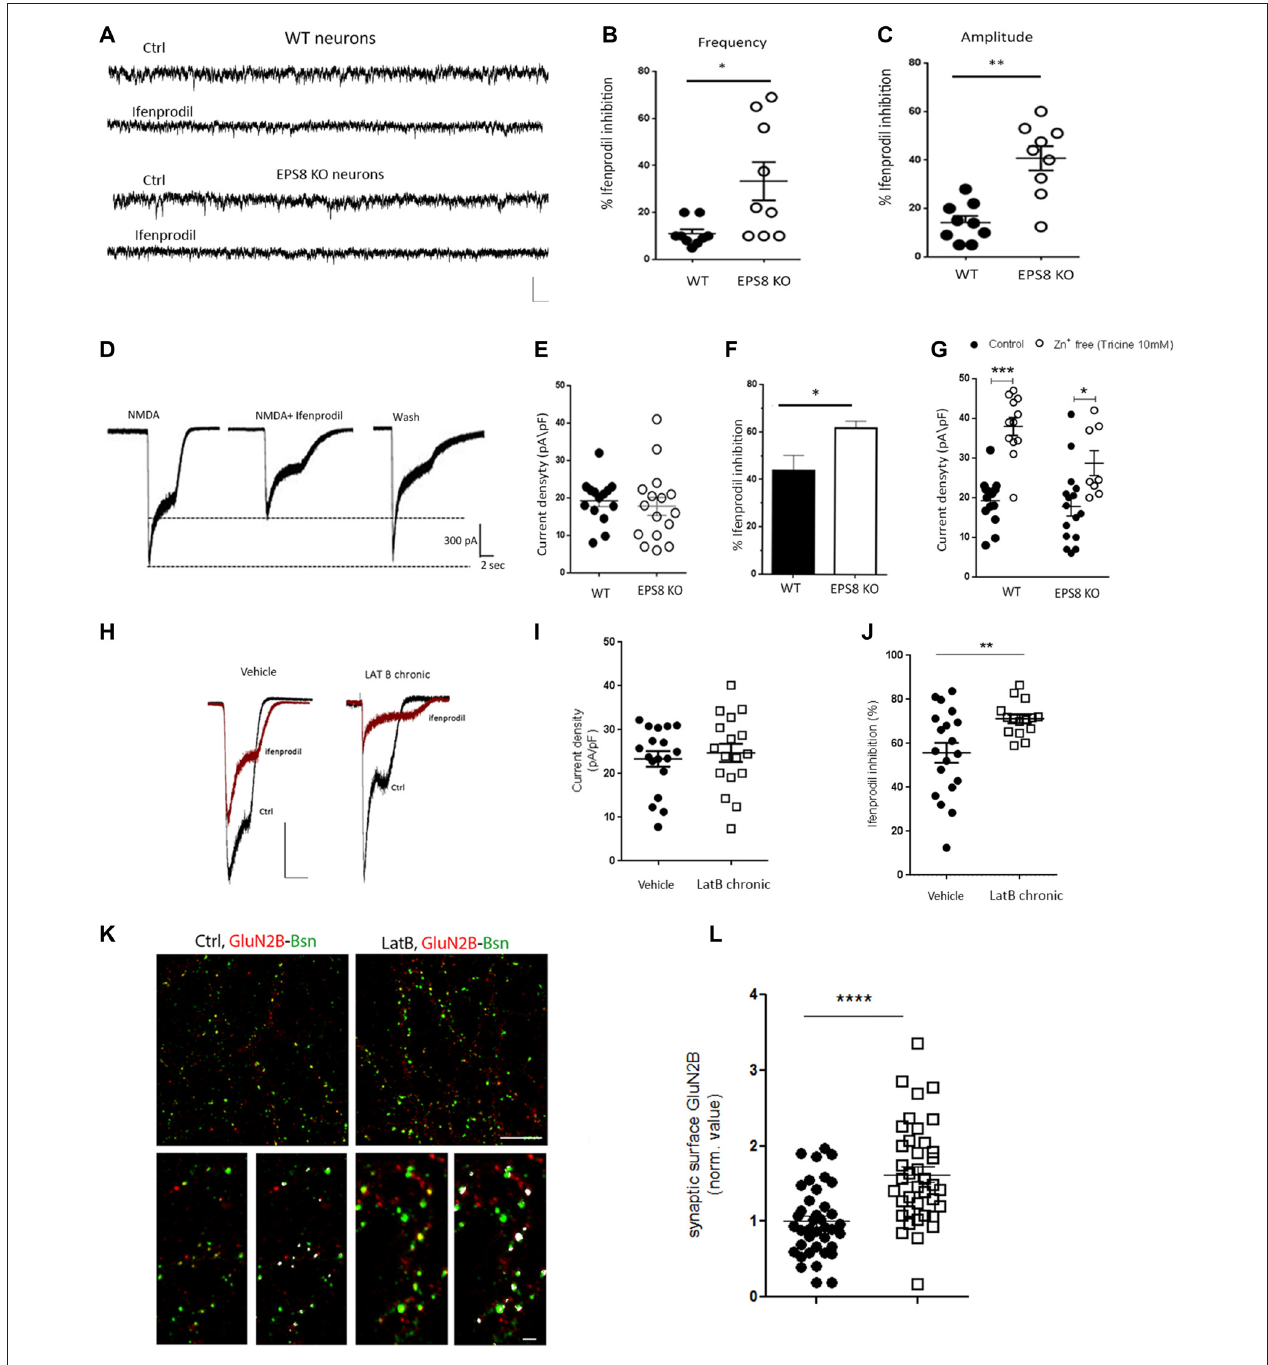
FIGURE 2 | Increased GluN2B and reduced GluN2A synaptic content of NMDARs in Eps8 KO neurons. (A) Representative traces of NMDAR mediated mEPSCs recorded from WT and EPS8 KO hippocampal neurons in the presence or not of the GluN1/GluN2B blocker Ifenprodil (3 µ M). Scale bar 10 pA, 50 ms. (B,C) Quantification of the inhibitory effect of ifenprodil on the NMDA-mEPSC frequency and amplitude respectively showing increased inhibition in KO neurons with respect to WT (B: Mann Whitney Test ∗ P = 0.0270; C: Unpaired t test ∗∗ P = 0.0065). (D) Examples of whole-cell currents elicited in WT and EPS8 KO hippocampal neurons by application of a saturating concentration of NMDA (200 µ m) in the presence or absence of GluN2B-selective antagonist ifenprodil (3 µ M). Scale bar 300 pA, 2 s. Quantitation of current density (E) , %age of ifenprodil inhibition (F) showing a larger amount of ifenprodil-dependent inhibition in KO neurons with respect to WT (Mann Whitney Test ∗ P = 0.0127). (G) Summary distribution graph of whole-cell currents elicited in WT and EPS8 KO treated or not with tricine (10 mM) showing a reduced GluN2A-dependent increase of current density upon tricine exposure in KO neurons with respect to WT (Mann Whitney Test, ∗∗∗ P < 0.001 and ∗ P = 0.0220). (H) Representative traces of whole-cell currents elicited in Vehicle and Latrunculin B (LatB)-treated neurons by application of